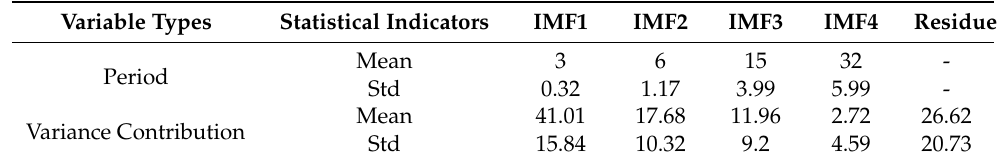
Figure 6. EEMD analysis of the average NPP changes during 1982–2015. IMF1-IMF 4 and Residue representing variations on different time scales and long-term trend, respectively. Table 6. Variance contribution rate (VC, %) and average period (year) of the average NPP change of all pixels on different time scales.